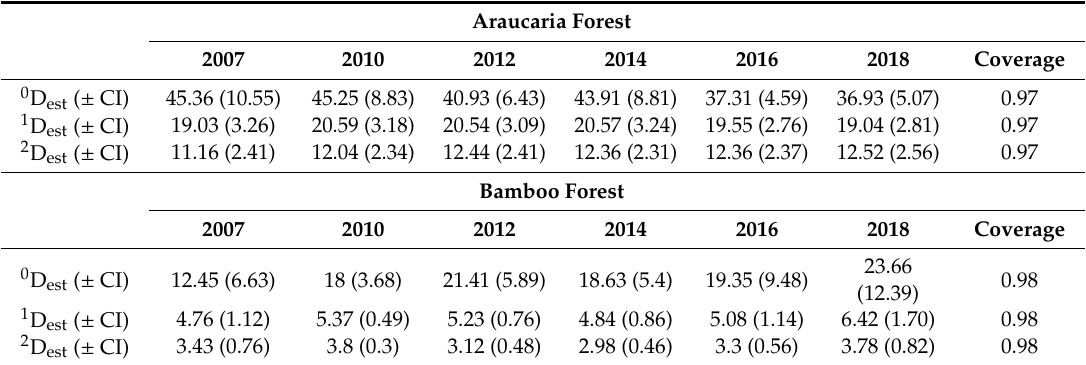
Table 2. Estimated Hill numbers ( q D est ; q = 0 to 2) for Araucaria Forest and Bamboo Forest during the 2007–2018 period. Araucaria Forest results compared at 0.97% of sample coverage and Bamboo Forest at 0.98%, with 95% confidence intervals ( ± CI) ( q = 0 is richness; q = 1 e ff ective number of species where species are weighted in proportion to their frequencies; q = 2 e ff ective number of species where more weight is given to abundant species, discounting rare species).